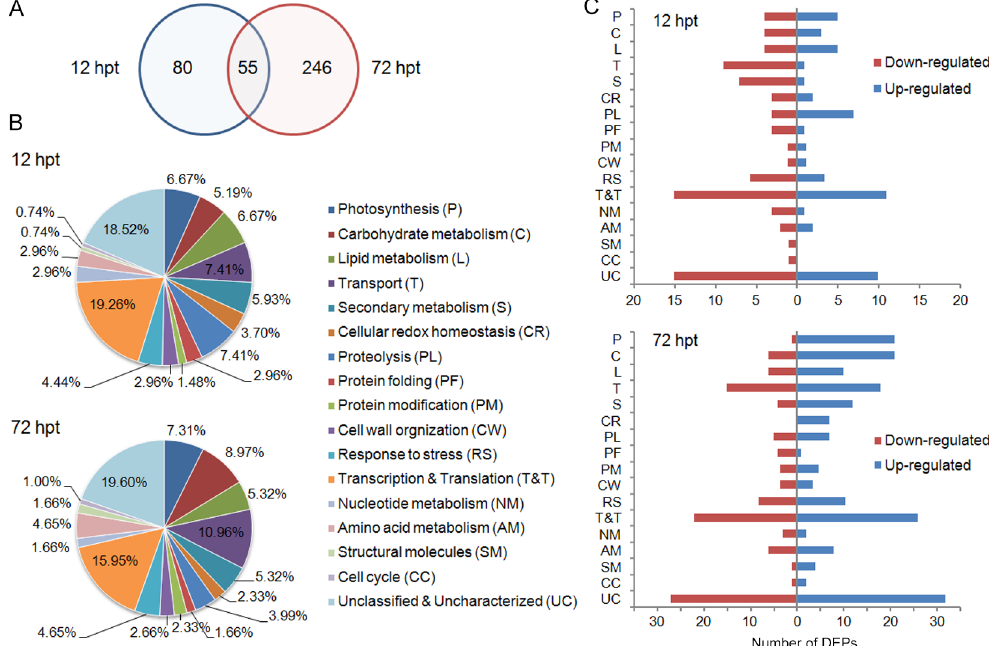
Fig 2. Distribution and functional classification of the 381 SA-responsive DEPs. (A) The numbers of SA- responsive DEPs that were identified at 12 hpt, 72 hpt or both time points are shown in the Venn diagram. (B) Functional classification and distribution of the DEPs via the GO and KEGG databases. (C) The number of DEPs that were up-regulated or down-regulated is also given for each category. The abbreviation for each functional category is indicated in (B). hpt, hours post